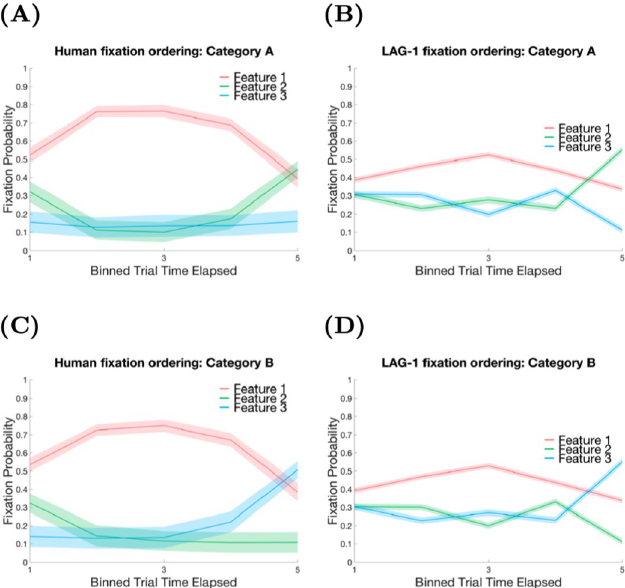
Fig 7. Fits to individuals. Data from three individual participants for fixation count, fixation duration, and accuracy. Below each participant are LAG-1’s fits to that participant’s data. Though the fits are not perfect in all cases, the model is showing both more and fewer fixations (counts), shorter and longer fixations (in milliseconds), and slower and faster learning (proportion correct) in accordance with individual differences.